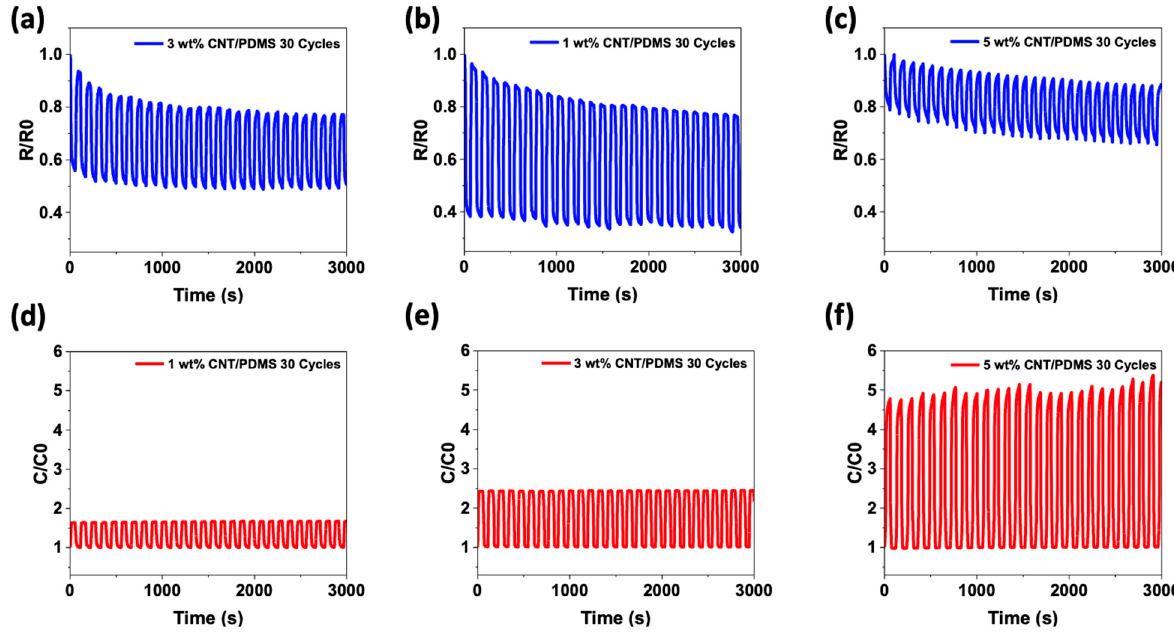
Figure 5. Normalized change in ( a – c ) resistance (R/R 0 ) and ( d – f ) capacitance (C/C 0 ) under cyclic pressure deformation at 50 kPa with varying contents of CNTs in the composites: ( a , d ) 1 wt%, ( b , e ) 3 wt%, and ( c , f ) 5 wt% CNT/PDMS.